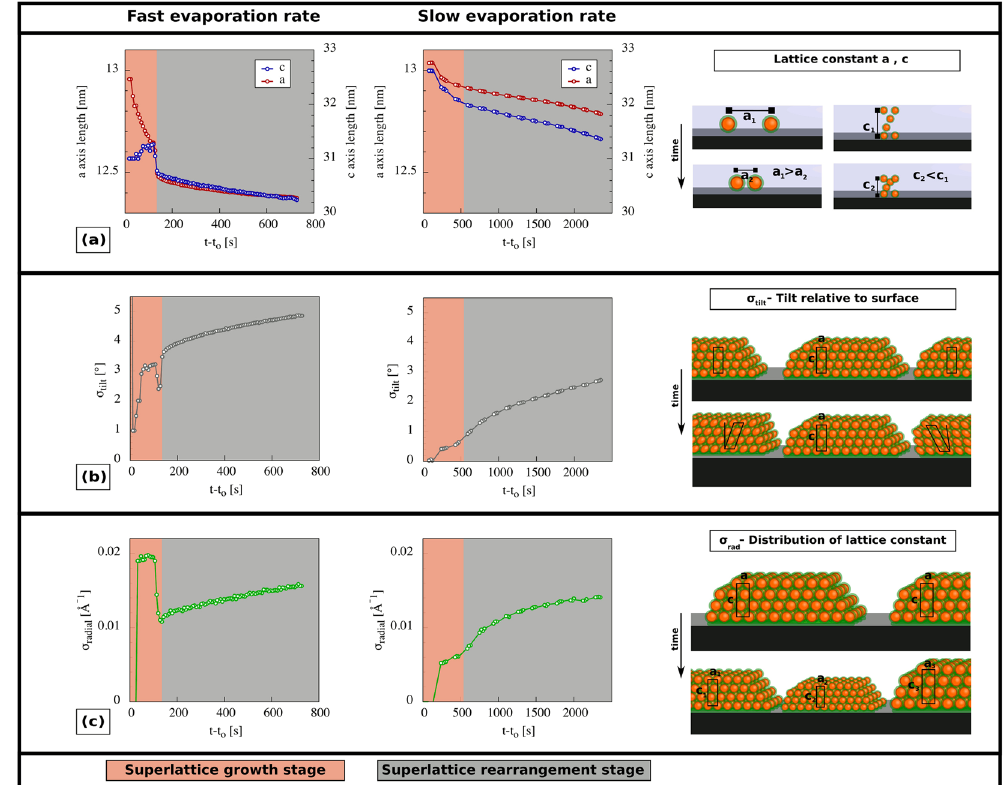
Figure 6. Structural transitions during superlattice growth and rearrangement. Time-dependent changes during drop casting at fast and slow evaporation rates of; (a) lattice constants; (b) unit cell tilt; and (c) distribution of lattice cell constants of the